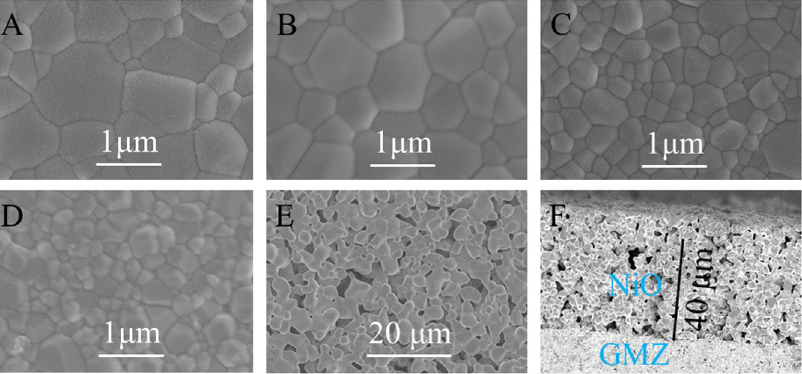
Figure 4. SEM images of the top-view of ( A ) Gd 2 Zr 2 O 7 , ( B ) Gd 1.95 Ca 0.05 Zr 2 O 7 + δ , ( C ) Gd 1.95 Sr 0.05 Zr 2 O 7 + δ , ( D ) Gd 1.95 Ba 0.05 Zr 2 O 7 + δ substrates calcined at 1500 °C for 4 h; ( E ) the surface of NiO electrode; ( F ) cross-section image for the NiO porous